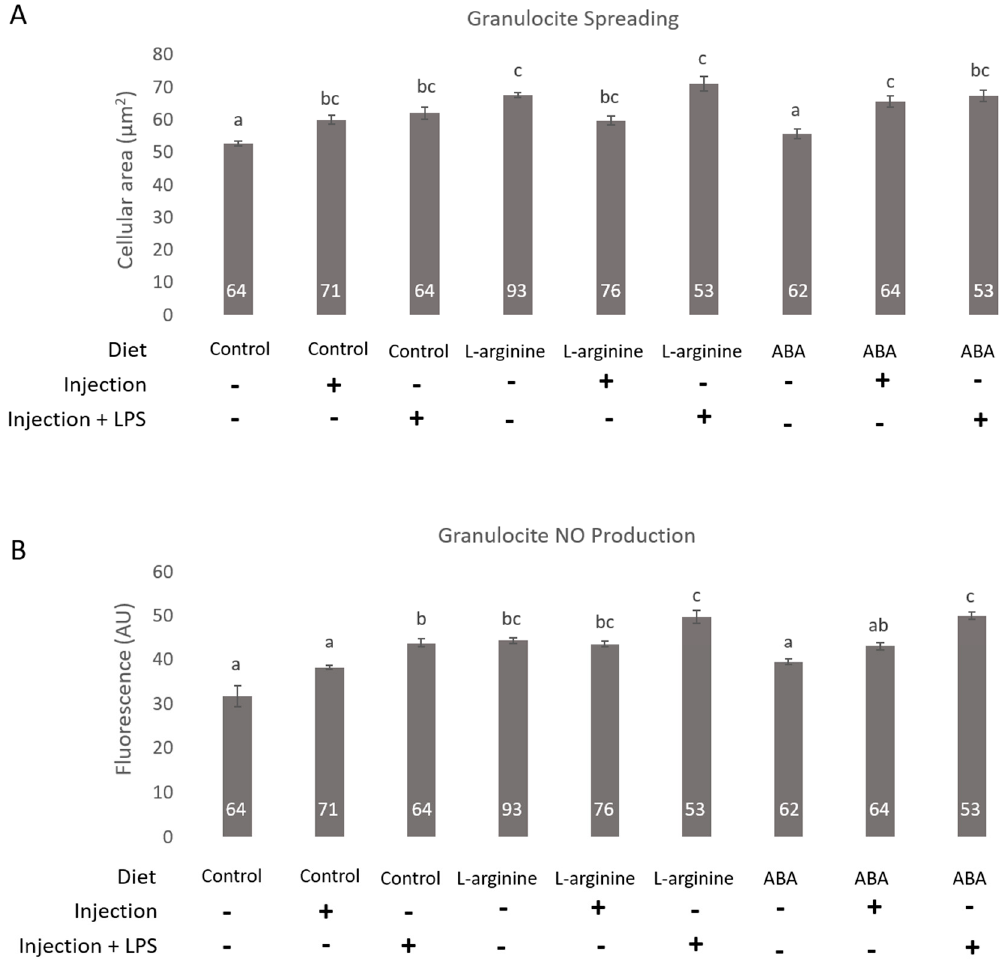
Figure 1. Effects of dietary L -Arginine and abscisic acid (ABA) over granulocyte spreading and NO production in response to lipopolysaccharide (LPS) in in vitro reared Apis mellifera larvae. Control: Larvae fed with the standard diet for in vitro rearing; L -Arginine: Larvae fed with the standard diet supplemented with 5 mM L -Arginine; ABA: Larvae fed with the standard diet supplemented with 50 µ M ABA. LPS: lipopolysaccharide (1 mg/mL). ( A ) Cellular spreading was measured as cellular area (mean ± SE) using ImageJ software from pictures obtained with a photographic camera coupled to the microscope; ( B ) NO production was measured using ImageJ from the green fluorescence emitted by the photographed hemocytes and expressed in arbitrary units (AU, mean ± SE). A Kruskal–Wallis analysis was applied ( p < 0.001) followed by the post hoc method for multiple comparisons of Dunn ( p < 0.05). Different letters means significant differences between treatments ( p < 0.05). The number of granulocytes evaluated are detailed in white numbers on the bases of the black bars.